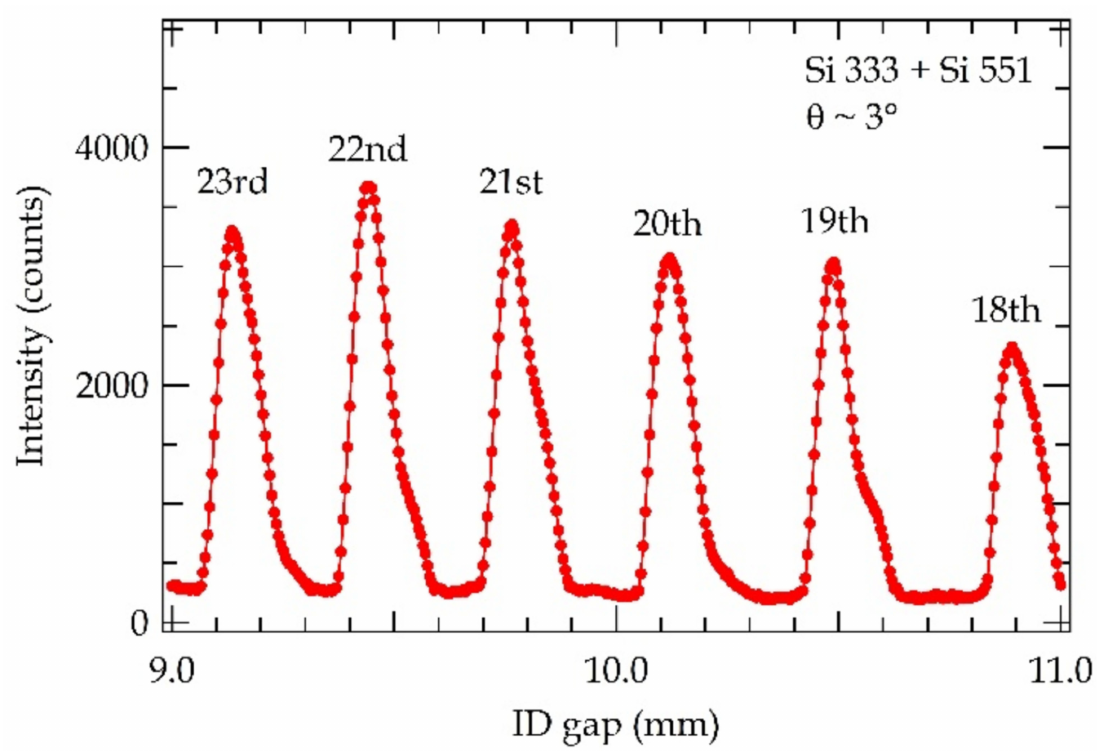
Figure 1. Observed X-ray intensities, which are monochromatized to 114 keV by a Si 333–Si 511 double crystal monochro- mator, with changing undulator gap. We can adjust the emission peak of a harmonics number of generated X-rays by tuning the undulator